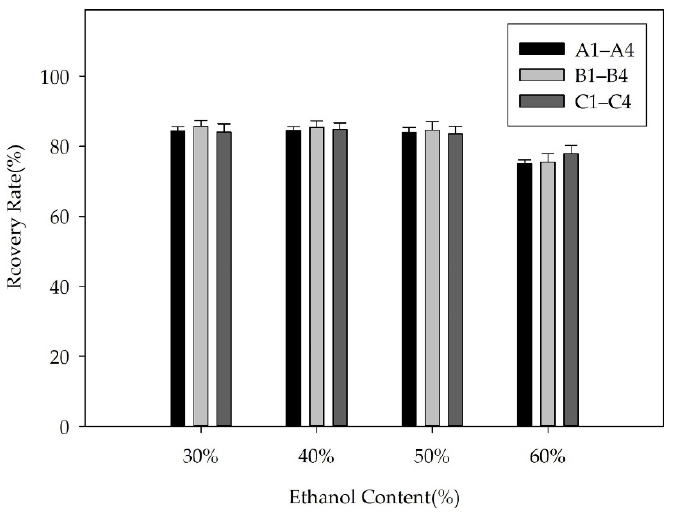
Figure 6. Purity of FX obtained from the solutions A1–A4, B1–B4, and C1–C4.